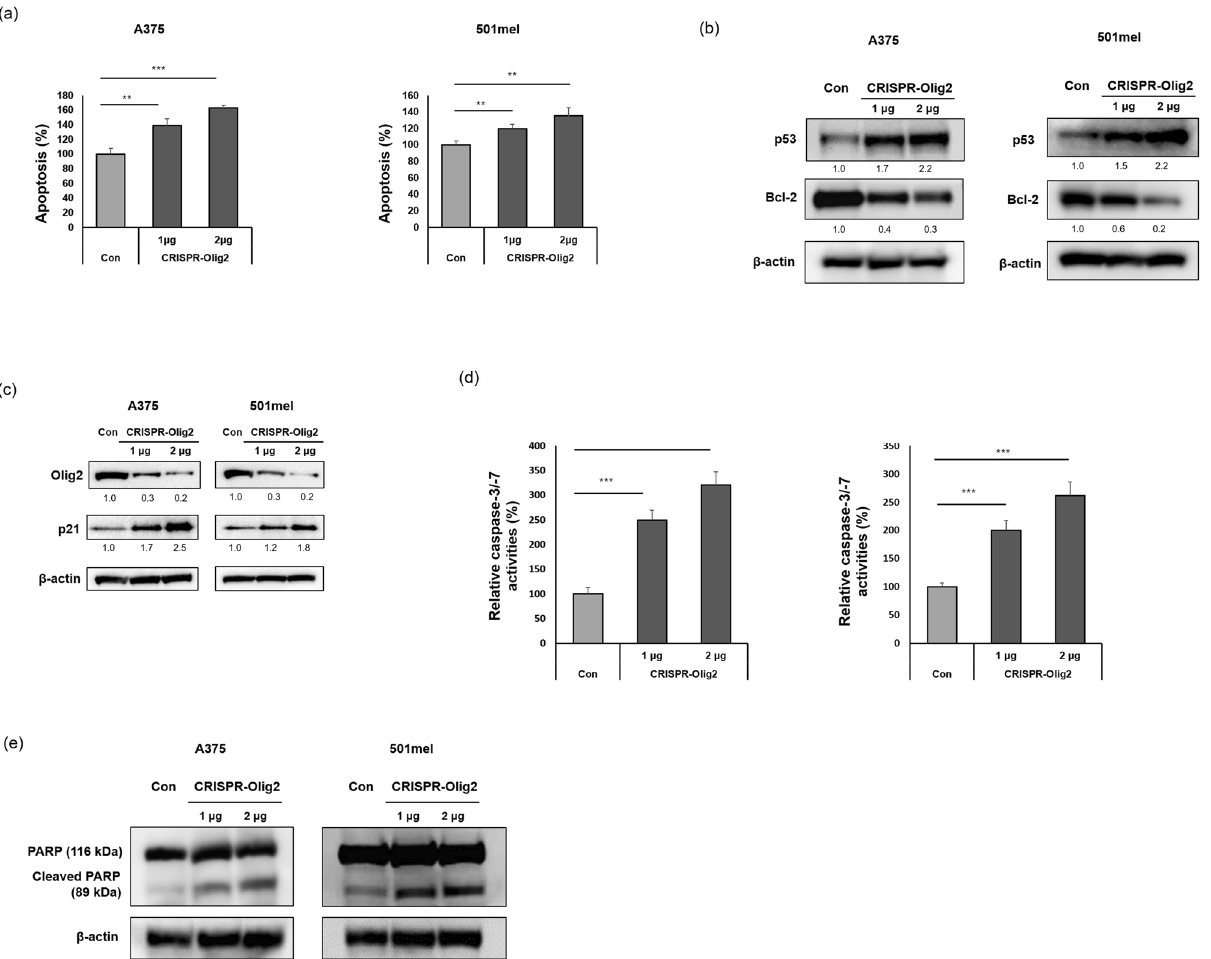
Figure 3. Downregulation of Olig2 induced p53-mediated apoptosis. ( a ) Apoptotic cells were detected using RealTime Glo Annexin V apoptosis assay kit. 24 h after transfection, the intensity of luminescence was recorded using a luminescence plate reader (** p < 0.01; *** p < 0.001 versus Con cells, n = 3). ( b ) Protein expression of Olig2, p53 and Bcl-2 was detected in A375 and 501mel melanoma cells by western blot analysis with Olig2 (H-10) antibody. β-actin was used as loading control. The band intensity was quantified using NIH ImageJ software 1.45 s. ( c ) Protein expression of Olig2 and p21 in A375 and 501mel melanoma cells by western blot analysis. ( d ) The activities of caspases-3/-7 were evaluated using Caspase-Glo 3/7 assay kit. 24 h after transfection, fluorescence intensity was detected at 485 nm excitation and 520 nm emission on a fluorescence plate reader (*** p < 0.001 versus Con cells, n = 3). ( e ) PARP and cleaved PARP expression in two melanoma cells transfected with negative control (Con) or CRISPR/Cas9-Olig2 plasmid (CRISPR-Olig2) (1 μg and 2 μg, respectively) was detected by western blot analysis. Original images of blots were provided in supplementary